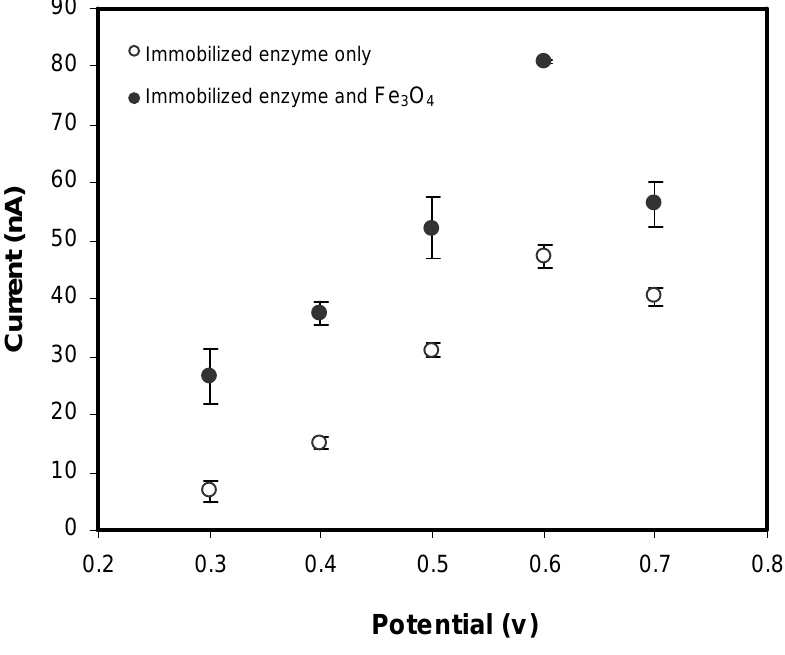
Figure 3. The hydrodynamic voltammograms (0.3 to 0.7 V) of the enzymic reaction between ALP and AA2P (80µM) for biosensor with ALP or ALP and Fe in a sol gel/chitosan